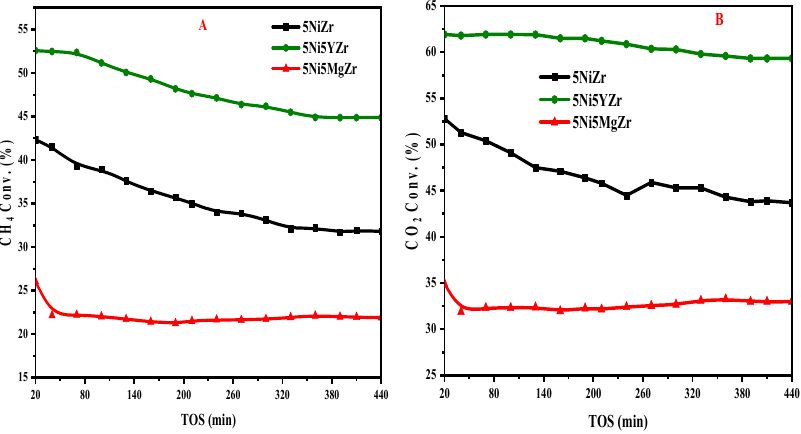
Figure 1. ( A ) CH 4 conversion %; ( B ) CO 2 conversion % against time on stream (TOS) for the potential modifiers at a reaction temperature of 700 °C.